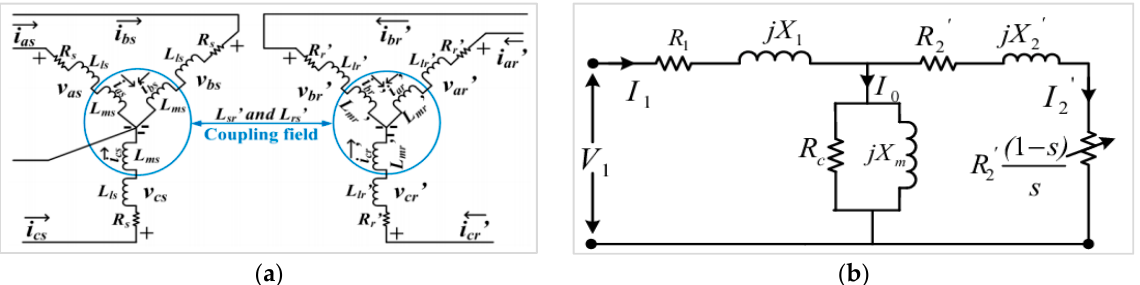
Figure 3. ( a ) The classical induction machine model considers only copper loss; ( b ) the steady-state per-phase equivalent circuit [27].